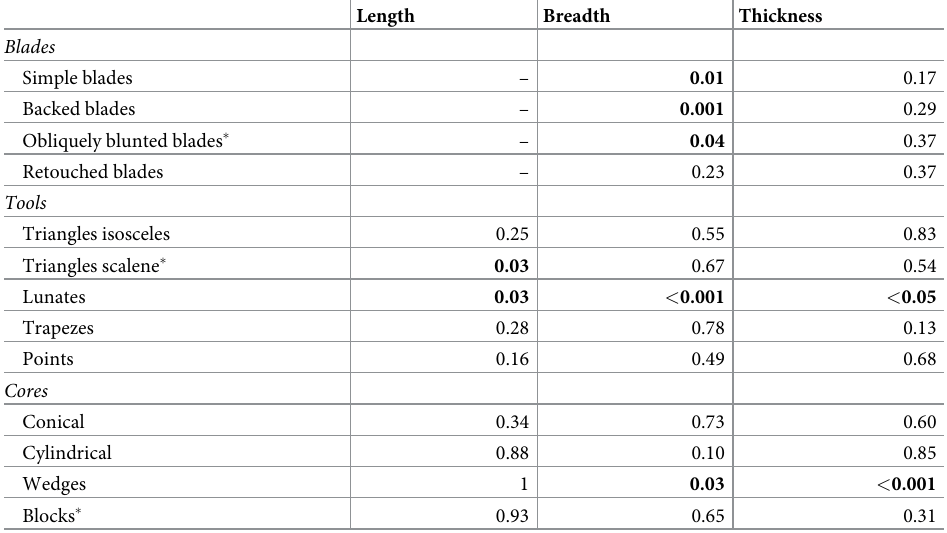
Table 4. Results of the Mann-Whitney-Wilcoxon tests (p-values) comparing the median and standard deviation of metric data from blades, tools and cores from Vaharvo Timbo and Loteshwar.